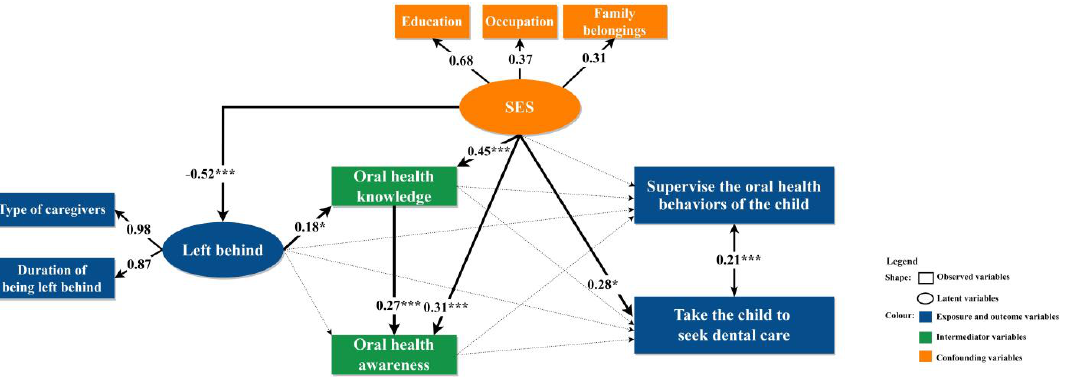
Figure 3. Structural equation modeling of the relationship between being left behind and compliance with advice. Note: The solid lines indicate significant relationships with the number on each line showing standardized path coefficients; the significant level for path coefficients was set at * p < 0.05, and *** p < 0.001; the dotted lines indicate insignificant relationships.